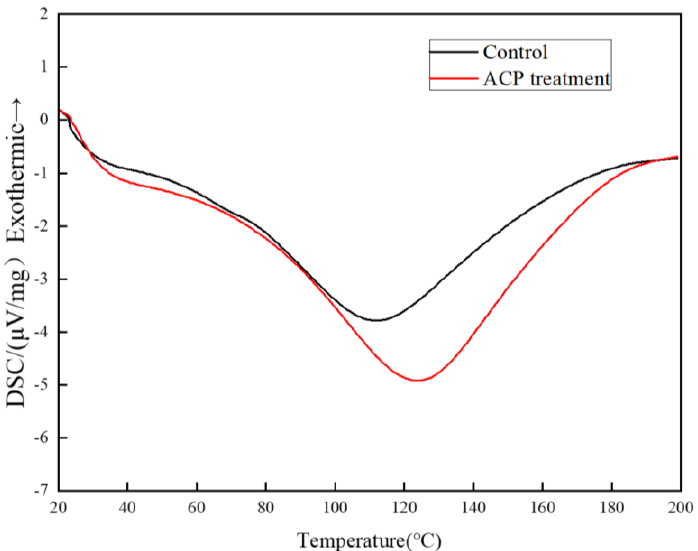
Figure 6. DSC curve of control and ACP–treated film at 30 kV for 3 min. Untreated soy protein film was considered as the control. The amount of soy protein was 10% and glycerol was 2.8%. Table 2. Thermodynamic parameters of control and ACP−treated film, with the amount of soy protein being 10% and glycerol being 2.8%.